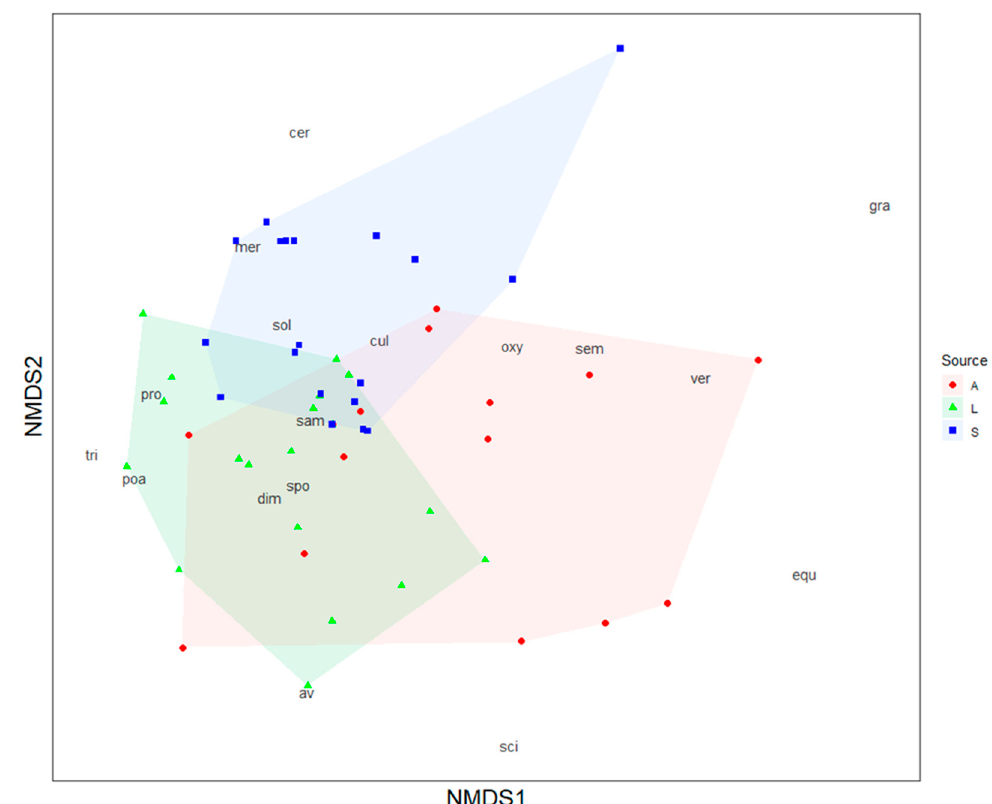
Figure 6. Non-metric multi-dimensional scaling (NMDS) ordination based on the Gower distance matrix of the Fusarium ( F .) species dominance structure, isolated from the body surface of ground- dwelling arthropods (A), from litter samples of kettle hole margins (L), or soil from the adjacent winter wheat field (S). Resemblance in the dominance structure between the three substrate is shown in symbols. The symbols represent samples; samples that are very distinct from each other are further away in the plot. The abbreviations indicate Fusarium species. Species code: F. avenaceum (ave), F. crookwellense (cer), F. culmorum (cul), F. dimerum (dim), F. equiseti (equ), F. graminearum (gra), F. merismoides (mer), F. oxysporum (oxy), F. poae (poa), F. proliferatum (pro), F. sambucinum (sam), F. scirpi (sci), F. semitectum (sem), F. solani (sol), F. sporotrichioides (spo), F. tricinctum (tri), F. verticillioides (ver).